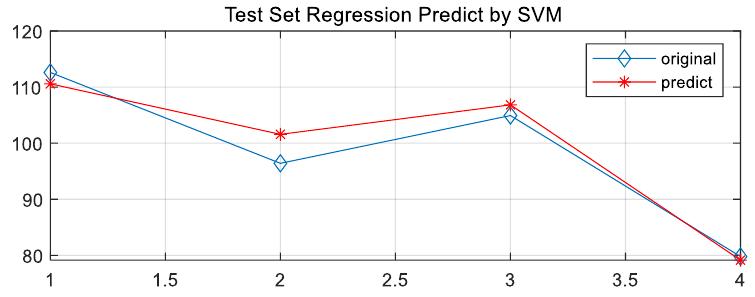
Figure 14. GA-cgp parameter optimization fitness curve.